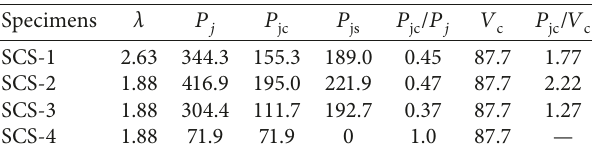
Figure 6: Load-displacement diagrams: (a) SCS-1, (b) SCS-2, (c) SCS-3, and (d) SCS-4. Table 2: Experimental load value